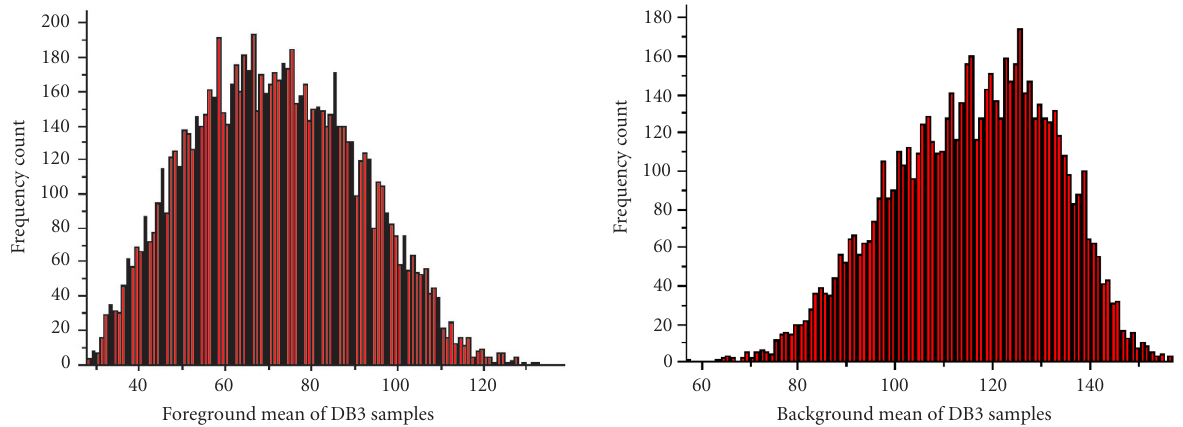
Figure 11: The block mean of the samples. The horizontal coordinate represents the value of the block mean while the vertical coordinate represents the frequency count of the value.